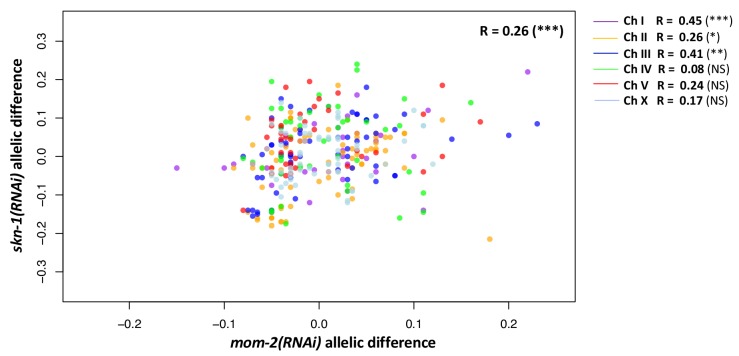
Correlation between the skn-1(RNAi) and mom-2(RNAi) allelic differences.Each dot represents a SNP, color-coded by chromosome. A small genome-wide correlation is observed, but significant for only three of the chromosomes individually. Represented here is a set of pruned SNPs (N = 321) to cover the whole genome, and corrected for LD (also used for calculations). Z-score is used to calculate median of each allelic group, correcting for outliers. Strength of correlation (Pearson’s R) represented. Significance levels: non-significant, p-value<0.05 (*), p-value<0.01 (**), p-value<0.001 (***).